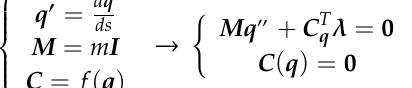
of freedom in space; for the translation q , its mass m is arbitrary because its value a ff ects only the Lagrange multiplier λ associated to the unique surface constraint C .